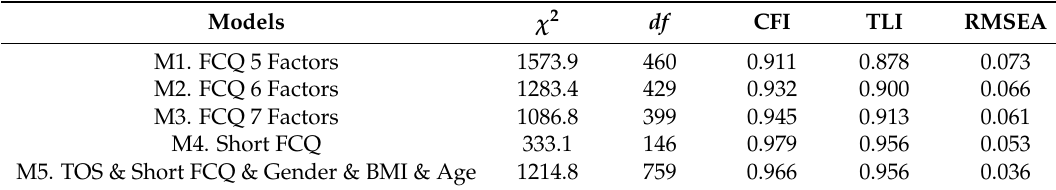
Table 1. Goodness of fit indices for the different